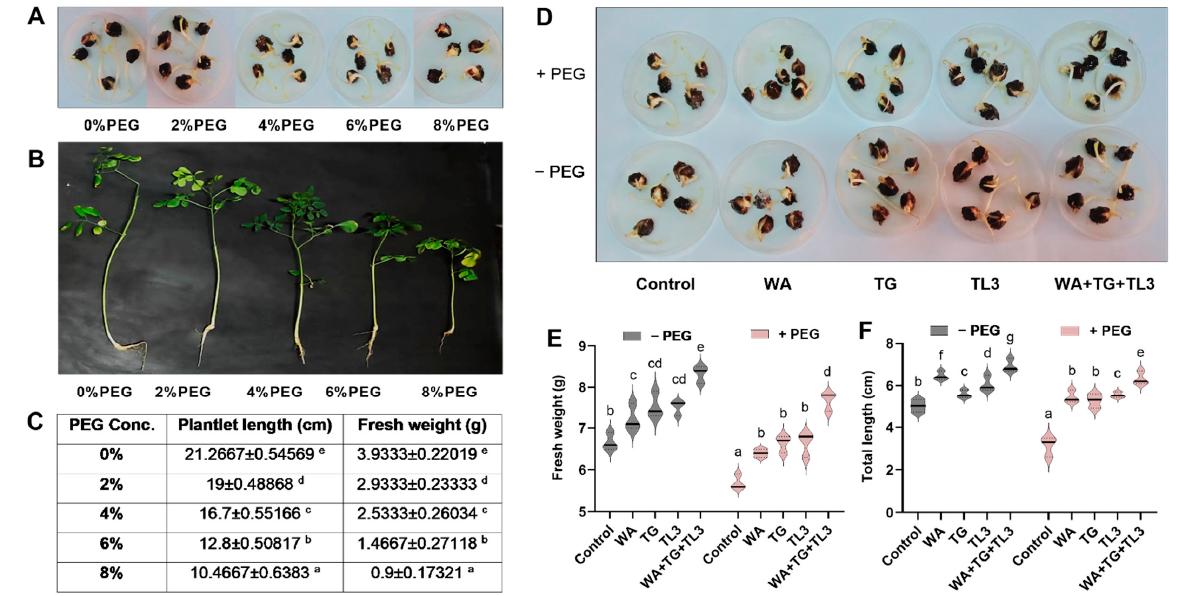
Figure 4. Assessment of PEG-mediated drought stress response of M. oleifera seed germination test. ( A ) Germination response in dose-dependent assay under PEG-induced drought conditions (0, 2, 4, 6, 8% PEG), ( B ) phenotypic evaluation of M. oleifera plantlets, ( C ) growth assessment of M. oleifera germinated plantlets (length and fresh weight), ( D ) seed germination response with endophytic fungal inoculation under control and drought stress, ( E ) seedling fresh weight and, ( F ) seedling length. Quantitative data represent means ± SE of three independent biological replicates presented with various letters showing differences at a significance level of p ≤ 0.05 using Duncan’s multiple range test